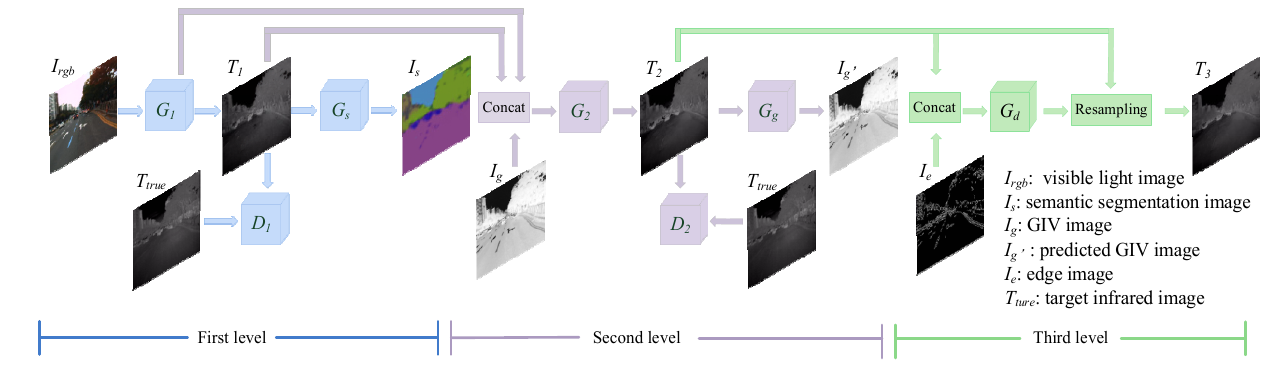
Figure 1. V2T-GAN network structure.